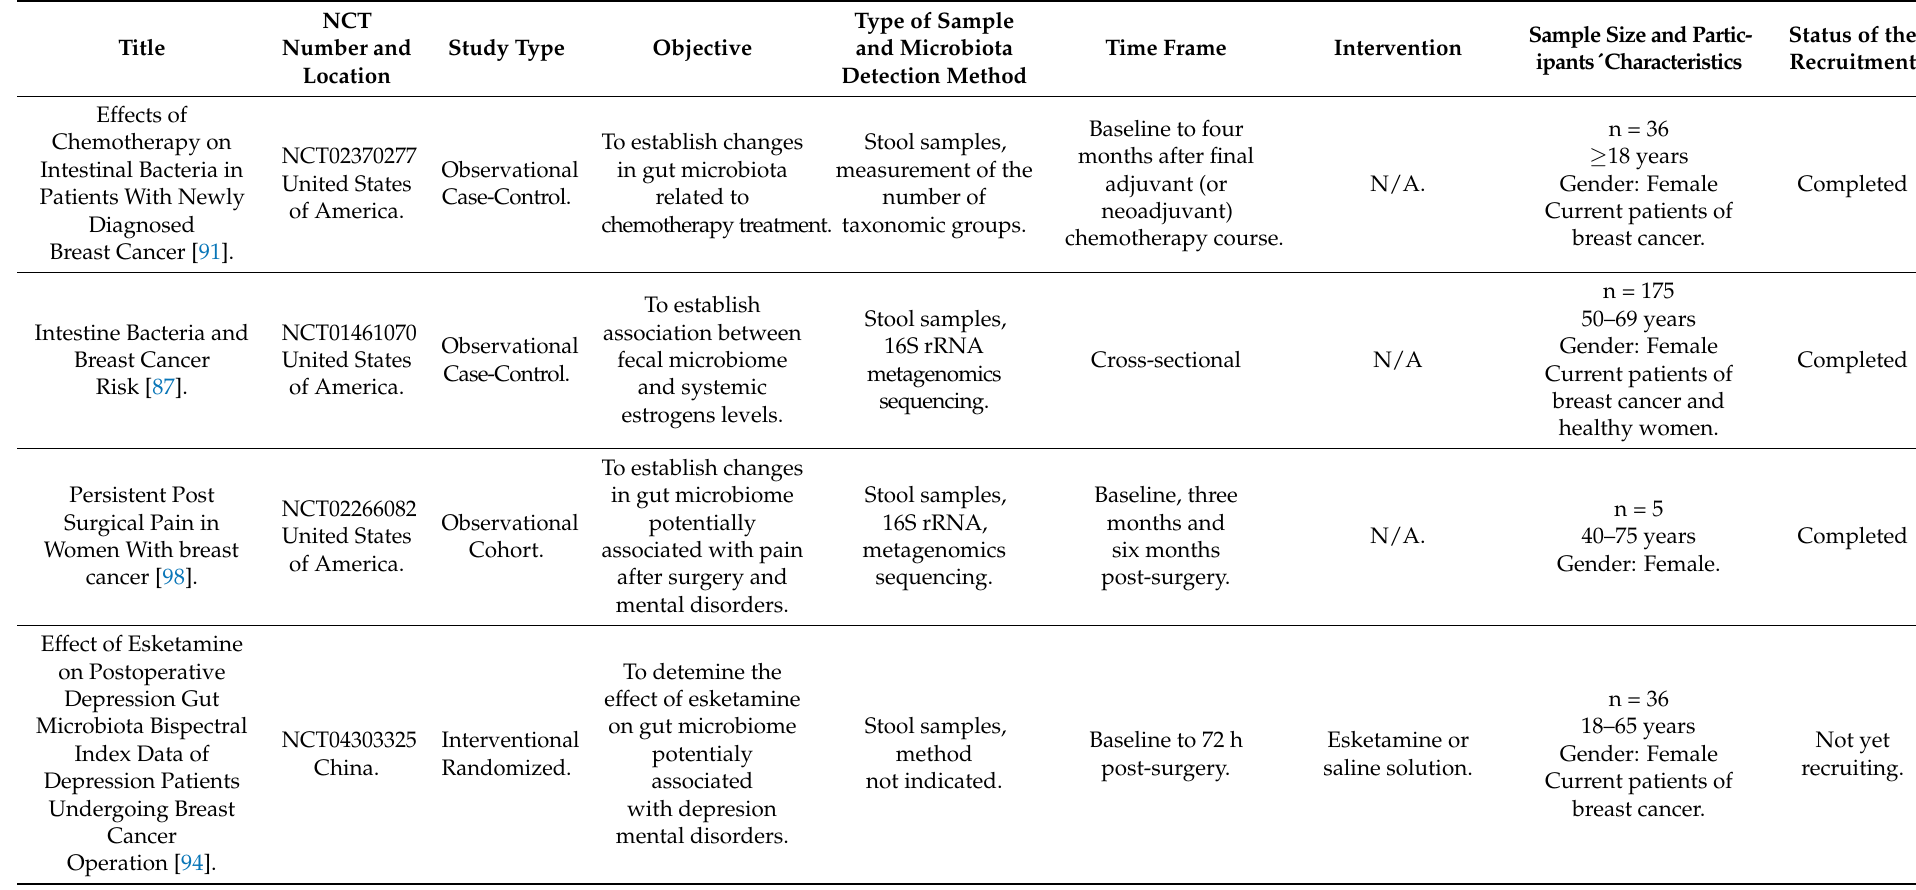
Table 2. Ongoing clinical studies registered on ClinicalTrials.gov dealing with breast cancer and